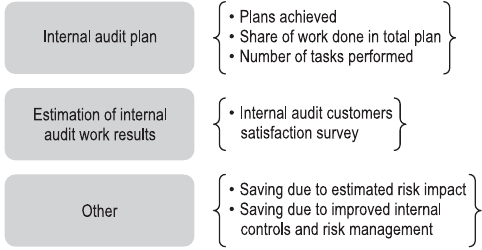
Fig. 7 . Internal audit effi ciency evaluation